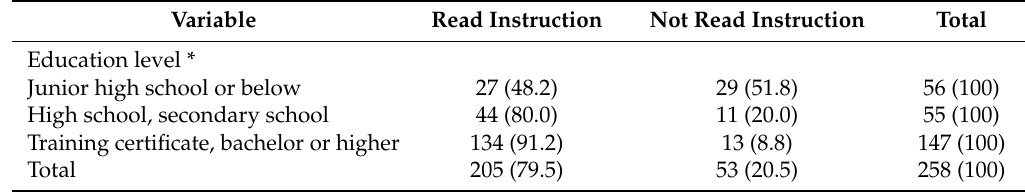
Table 4. The situation of reading instructions in different education level (person (%)). Variable